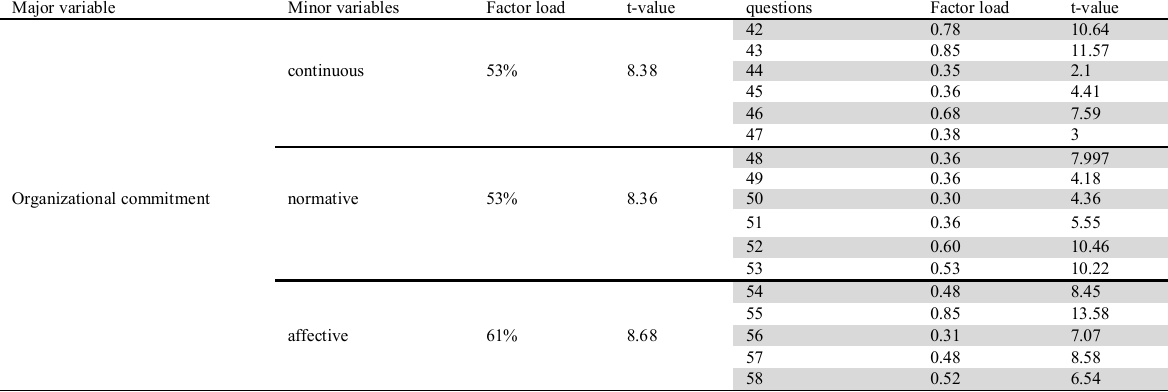
The standard factor load, meaningful statistics (t-value) scale of social capital Major variable